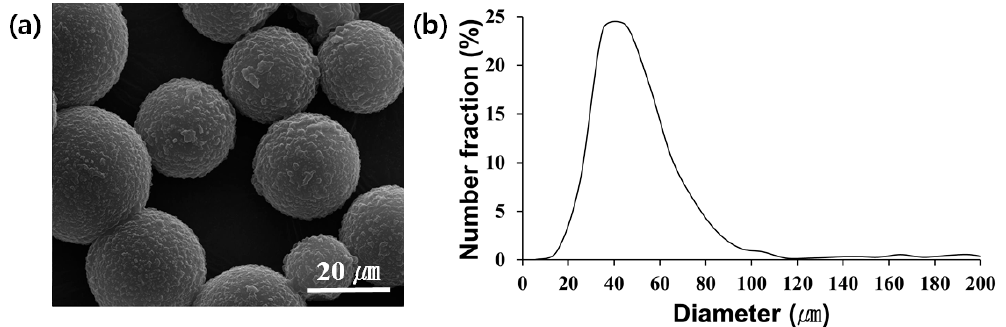
Figure 2. ( a ) SEM image of the linseed oil microcapsules; ( b ) Size distribution of the linseed oil microcapsules.